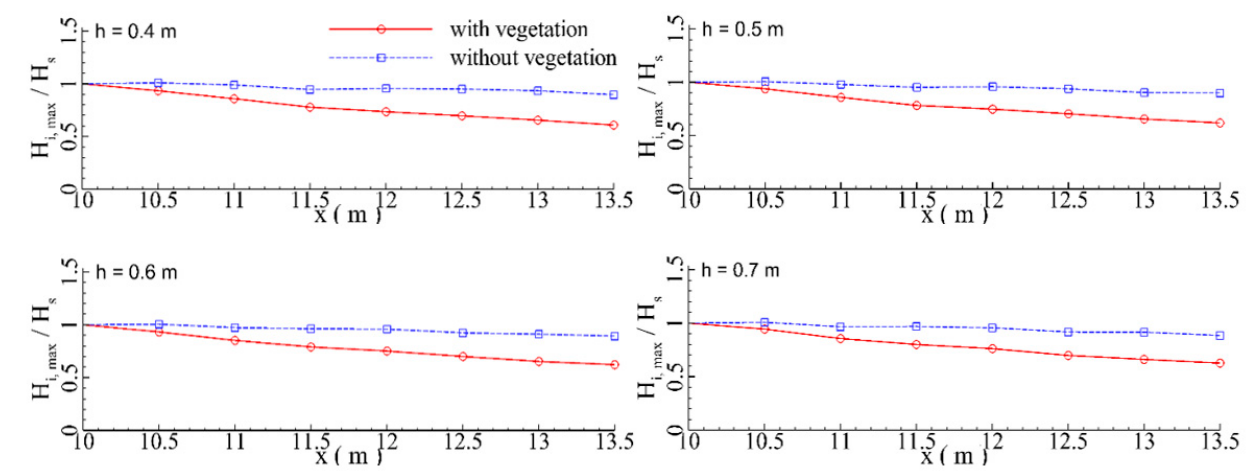
Figure 17. Spatial distributions of local maximum wave height under different water depths.